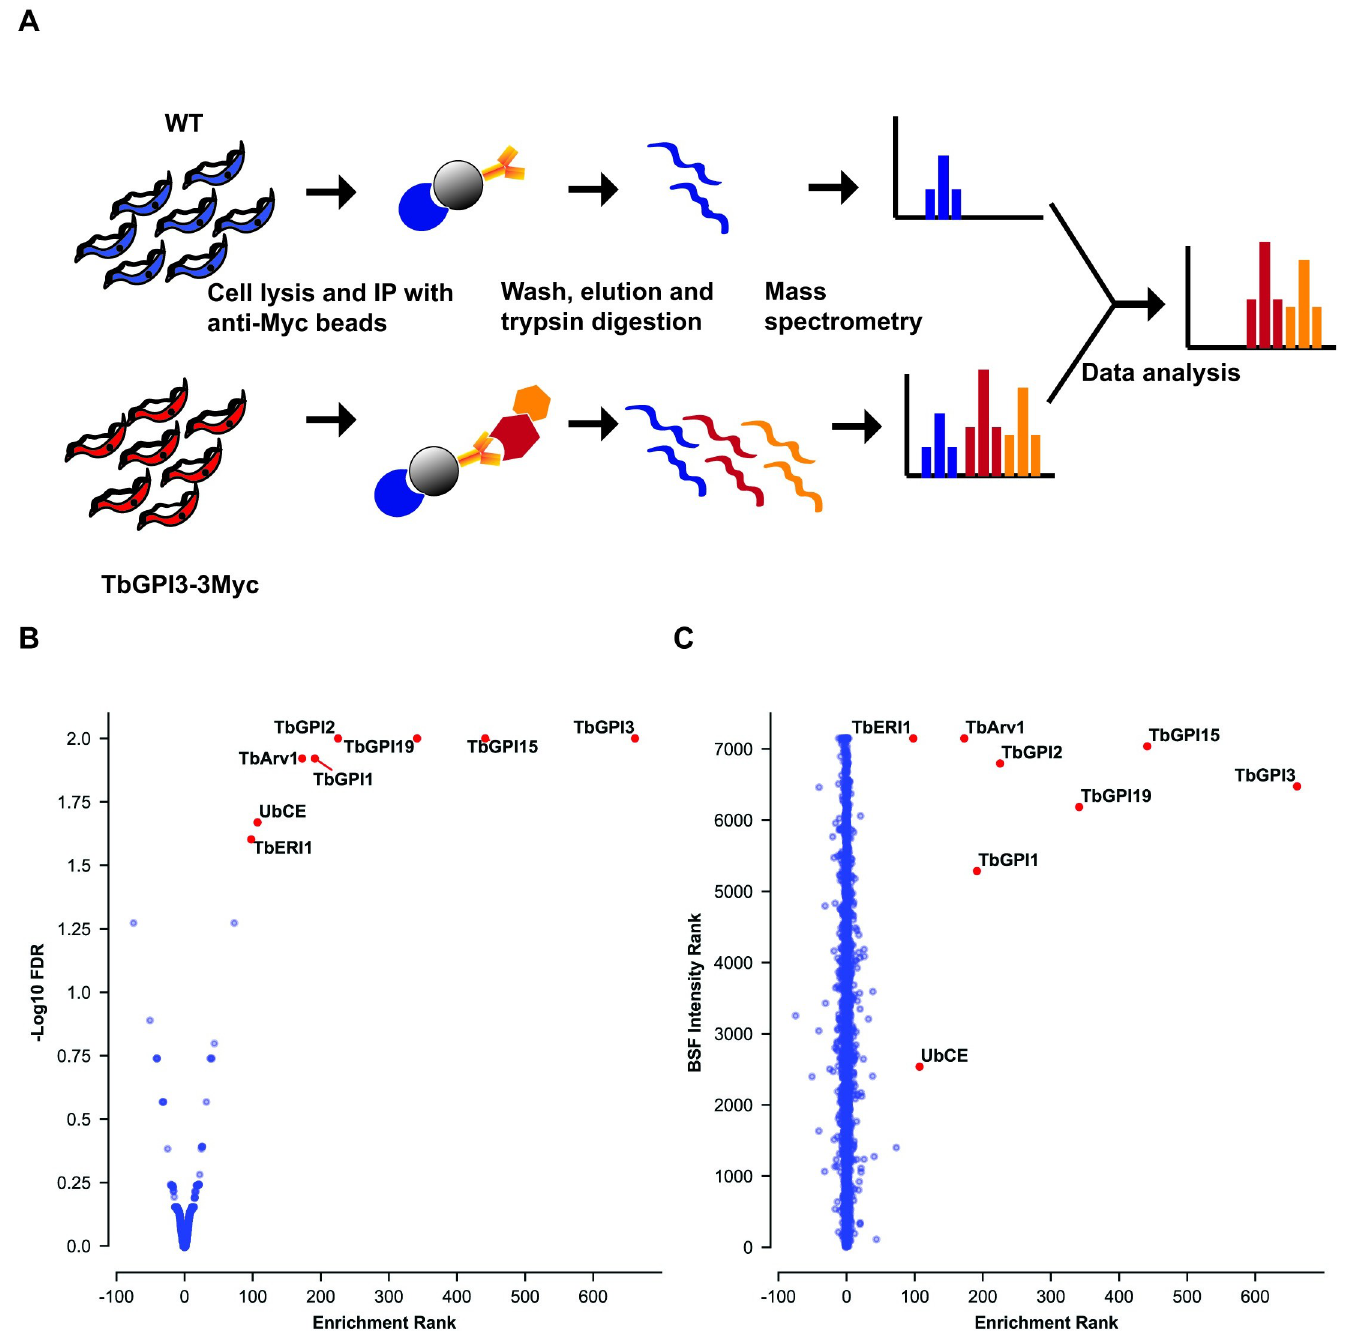
Fig 3. Identification of UDP-GlcNAc: PI α 1–6 GlcNAc-transferase subunits by immunoprecipitation of TbGPI3-3Myc from BSF T . brucei digitonin lysates. (A) Scheme of the label-free proteomics approach to identify TbGPI13-3Myc binding partners. BSF WT and TbGPI13-3Myc expressing cell lines were cultured, harvested and lysed in 0.5% digitonin lysis buffer. Identical quantities of the supernatants were subjected to anti-Myc agarose bead immunoprecipitation and the bound proteins were eluted from the beads with SDS sample buffer. The eluted proteins were reduced, alkylated and digested with trypsin and the resulting peptides analysed by LC-MS/MS. (B) Volcano plot comparing protein groups present in the anti-cMyc immunoprecipitates from TbGPI3-3Myc expressing cell lysates versus WT cell lysates. Mean values (from biological triplicate experiments) for each protein group (dots) are plotted according to their minus log10 False Discovery Rate values (y- axis), calculated by MaxQuant, and the enrichment rank (x-axis). The enrichment rank was computed with the ProtRank algorithm using the iBAQ values calculated by MaxQuant. The higher the rank value on the x-axis, the higher the abundance in the TbGPI3-3Myc samples. The putative subunits of UDP-GlcNAc: PI α 1–6 GlcNAc-transferase in T . brucei are highlighted in red and annotated with their corresponding names (Table 1). (C) Relative intensity plot using a new algorithm. The same data as (B) are plotted with a different y-axis, whereby each protein group is assigned an intensity rank from the most abundant protein group (1) to least